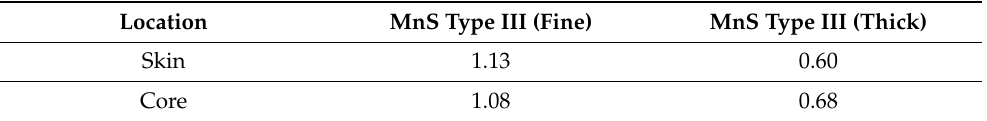
Figure 6. MnS type III ( a , b ), typical EDS observation of one of the particles ( c ). Table 4. Indexes of inclusion